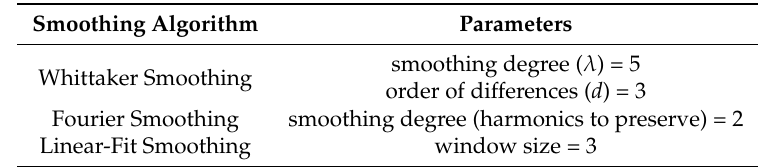
Table 2. Parameters used for smoothing algorithms.